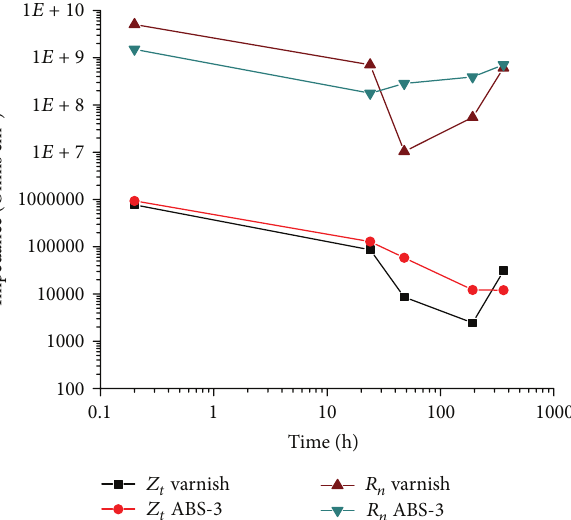
Figure 10: Comparative curves of 𝑍 𝑡 and 𝑅 𝑛 in time for varnish and polymer ABS coatings as a function of